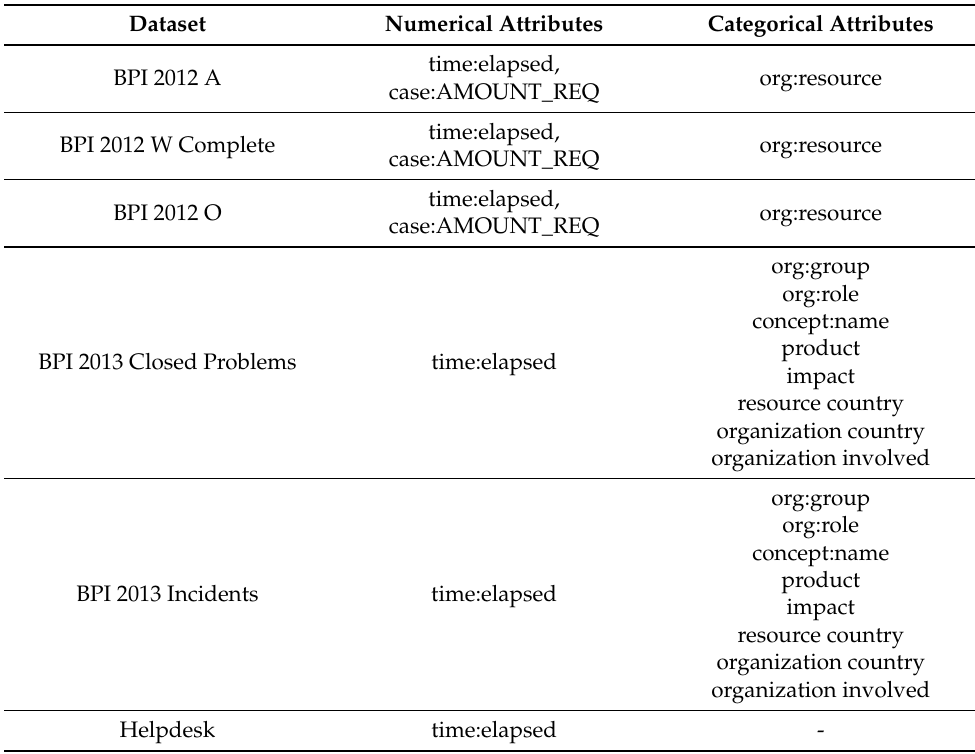
Table 4. Numerical attributes and categorical attributes used in the POP-ON model for the differ- ent